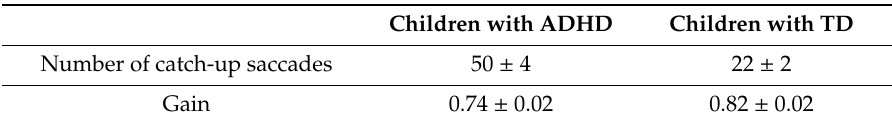
Table 2. Mean and SD values of the number of catch-up saccades and gain during pursuit for children with ADHD and